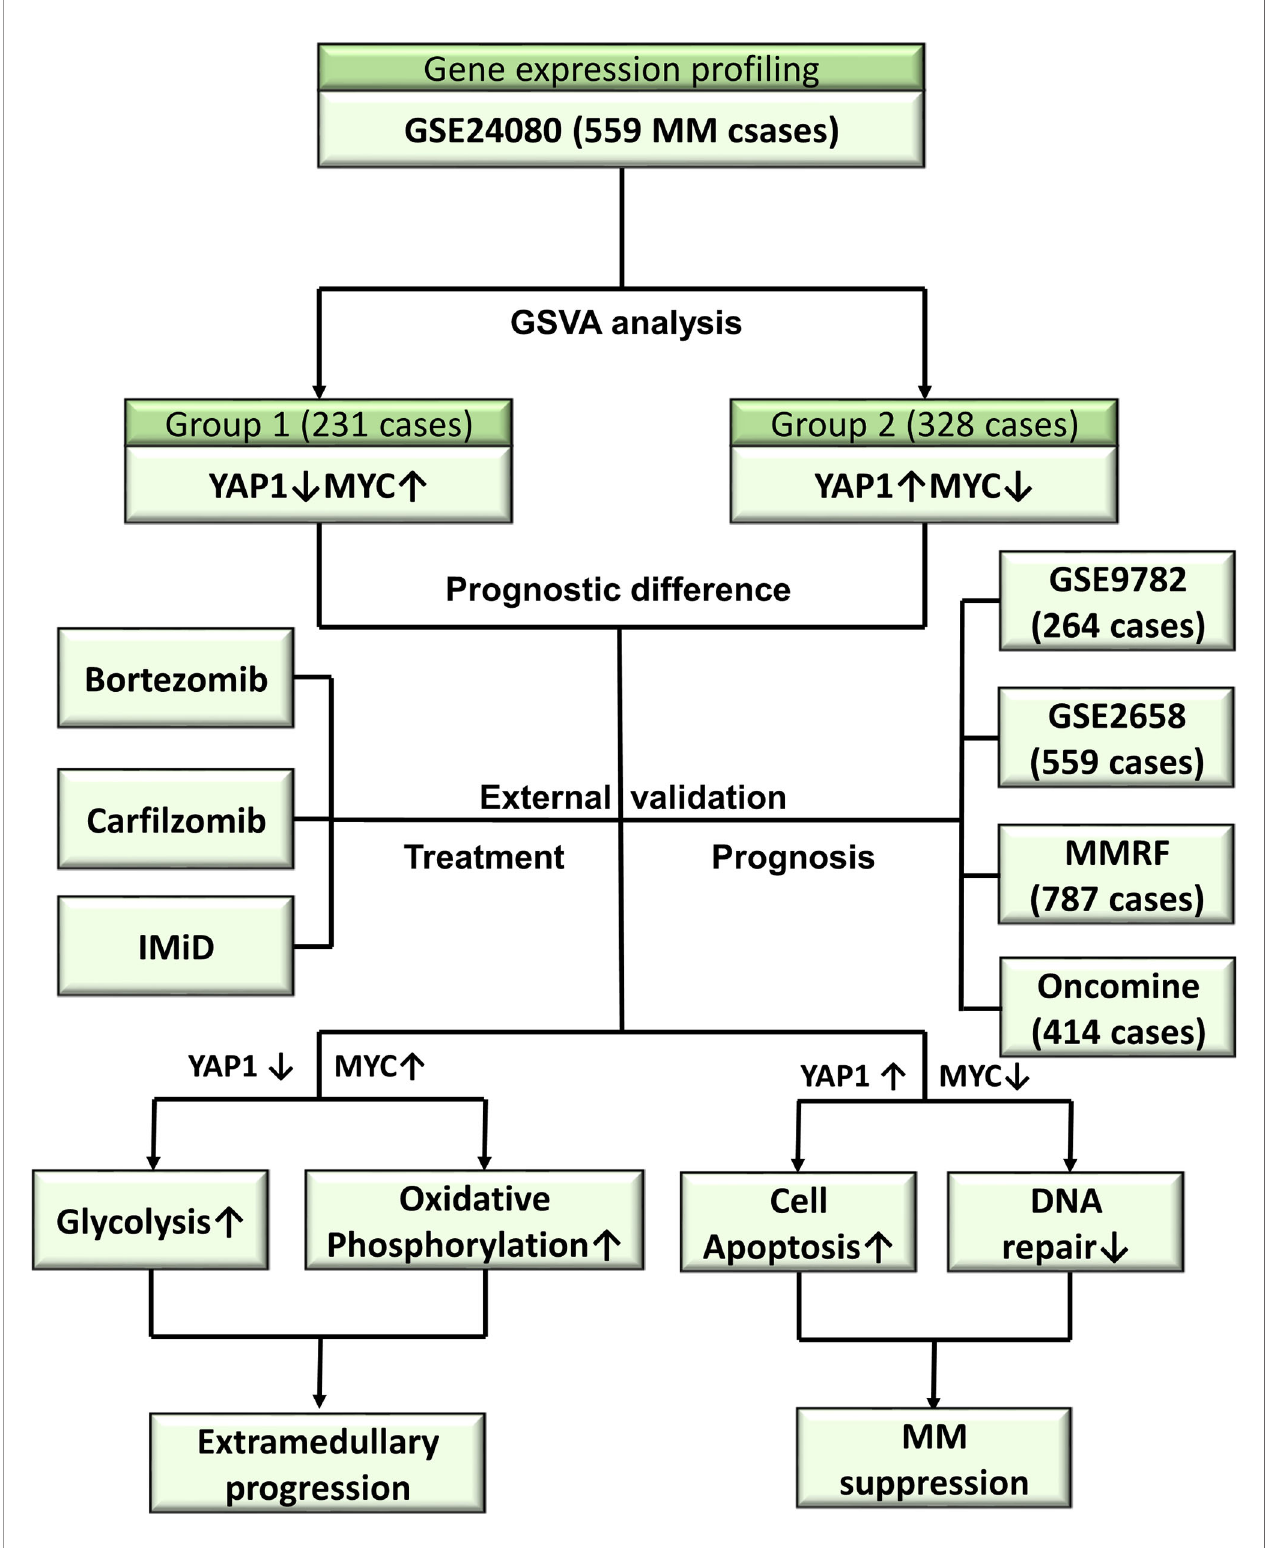
FIGURE 8 | Overview of the